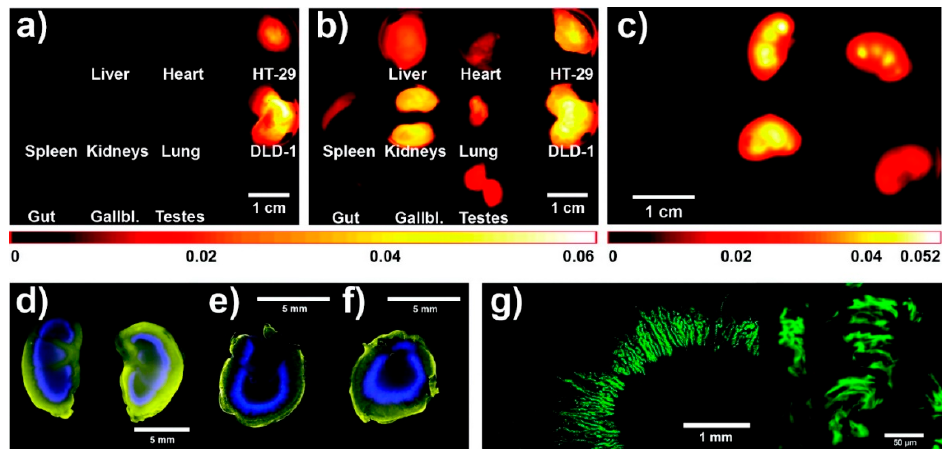
Figure 5. Ex vivo fluorescence images of organs and tumors: 2D-fluorescence reflectance imaging images of the model drug DY-676 ( a ) and HPMA copolymer ( b ) of mouse that was treated with star-like HPMA copolymer (polymer B); distribution of the model drug in kidneys 24 h after intravenous administration; left: placebo, middle: star-like HPMA, right: linear HPMA ( c ); pseudo-colored fluorescence images of kidney slices 24 h after i.v. injection—model drug: blue, HPMA polymer: yellow ( d – f ) (linear HPMA: d and e, star-like HPMA: f ); Confocal microscopic images of the model drug distribution in the kidney 24 h after i.v. injection of 1.5 mg linear HPMA (polymer A) ( g ). Reprinted with permission from [31], Copyright [2012], American Chemical Society.